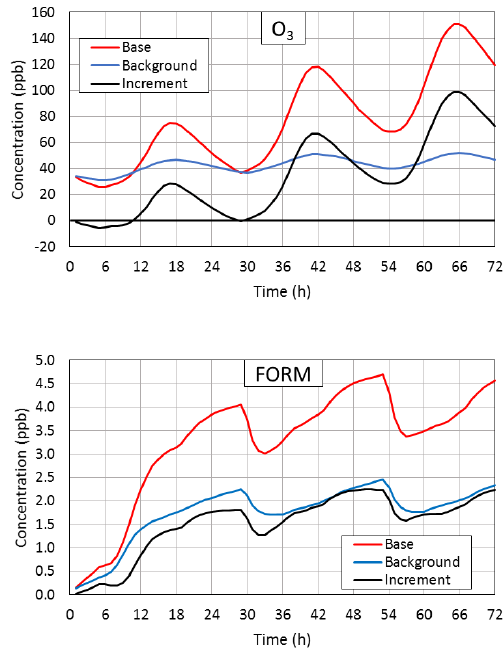
Figure 2. Results from the two-cell model simulations. Ozone and formaldehyde concentrations for the base case and the background case and the difference between them (anthropogenic